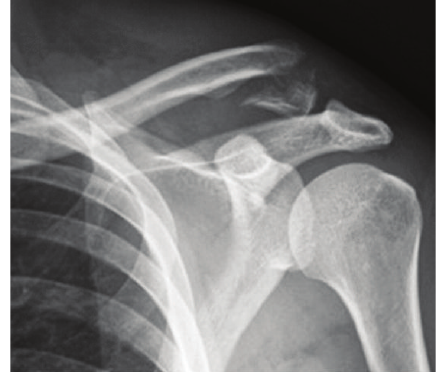
Figure 1: Initial radiographs prior to osteosynthesis.